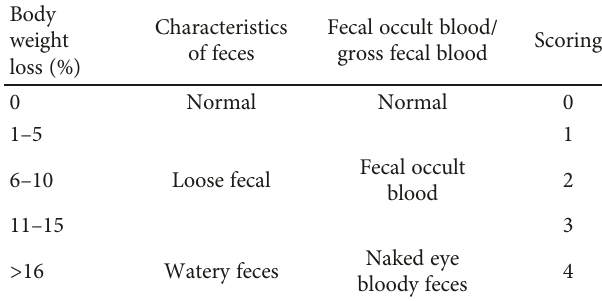
Table 1: Ulcerative colitis disease activity